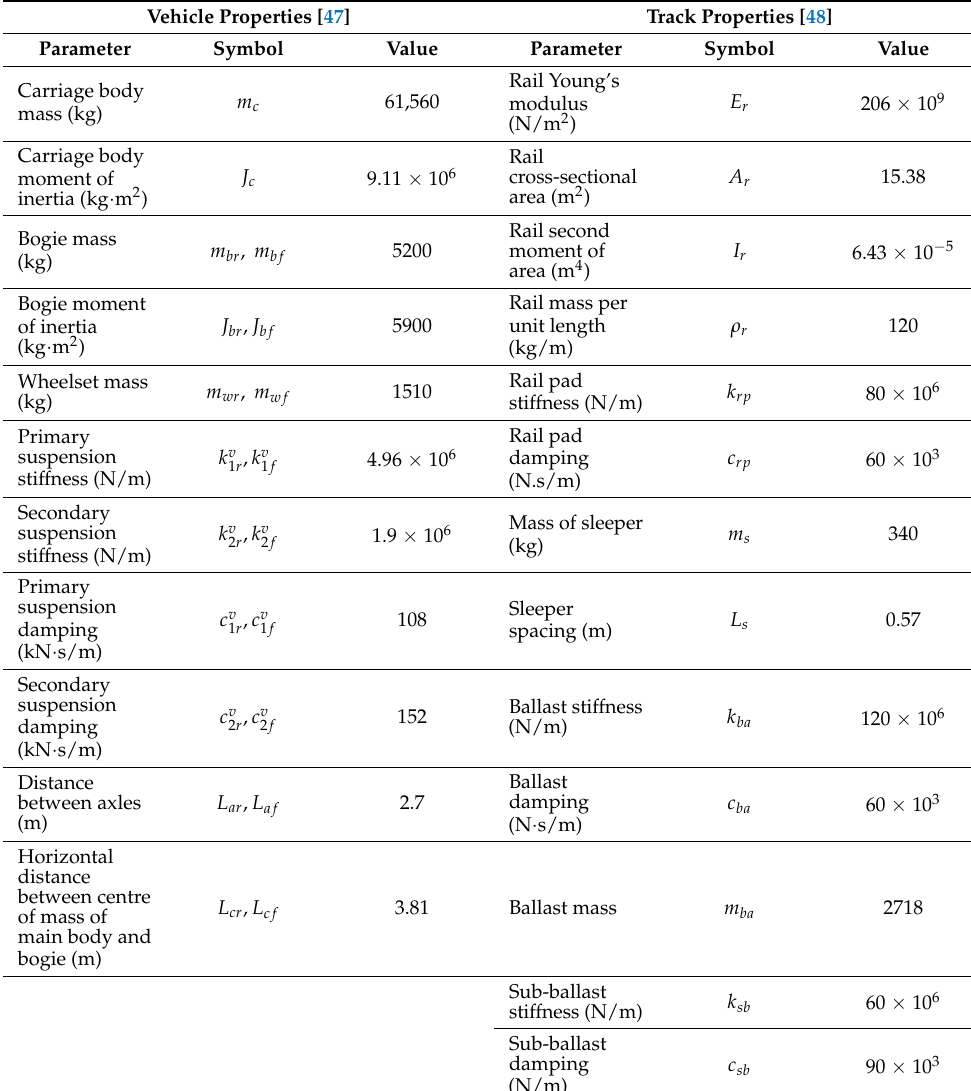
Table 1. Vehicle and track